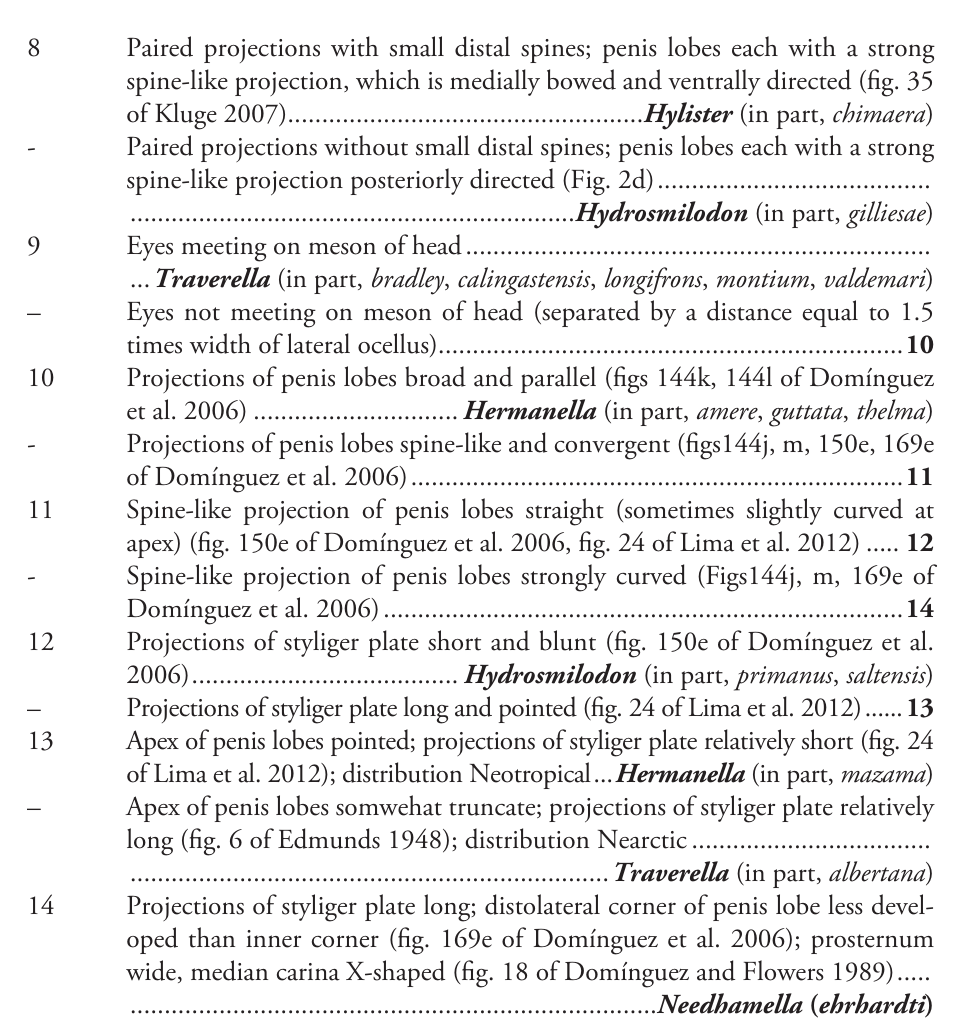
... Traverella (in part, bradley , calingastensis , longifrons , montium , valdemari ) – Eyes not meeting on meson of head (separated by a distance equal to 1.5 10 Projections of penis lobes broad and parallel (figs 144k, 144l of Domínguez - Projections of penis lobes spine-like and convergent (figs144j, m, 150e, 169e of Domínguez et al. 2006) ........................................................................ 11 11 Spine-like projection of penis lobes straight (sometimes slightly curved at apex) (fig. 150e of Domínguez et al. 2006, fig. 24 of Lima et al. 2012) ..... 12 - Spine-like projection of penis lobes strongly curved (Figs144j, m, 169e of Domínguez et al. 2006) ............................................................................ 14 12 Projections of styliger plate short and blunt (fig. 150e of Domínguez et al. – Projections of styliger plate long and pointed (fig. 24 of Lima et al. 2012) ...... 13 13 Apex of penis lobes pointed; projections of styliger plate relatively short (fig. 24 of Lima et al. 2012); distribution Neotropical ... Hermanella (in part, mazama ) – Apex of penis lobes somwehat truncate; projections of styliger plate relatively long (fig. 6 of Edmunds 1948); distribution Nearctic ................................... 14 Projections of styliger plate long; distolateral corner of penis lobe less devel- oped than inner corner (fig. 169e of Domínguez et al. 2006); prosternum wide, median carina X-shaped (fig. 18 of Domínguez and Flowers 1989) ..... – Projections of styliger plate short; distolateral corner of penis lobe more developed than inner corner (as in figs 144j, m of Domínguez et al. 2006); prosternum with narrow, straight median carina (fig. 144r of Domínguez et al. 2006) .......................................................................... Hermanella (in part, froehlichi , maculipennis , nigra ) / Hylister (in part, obliquus